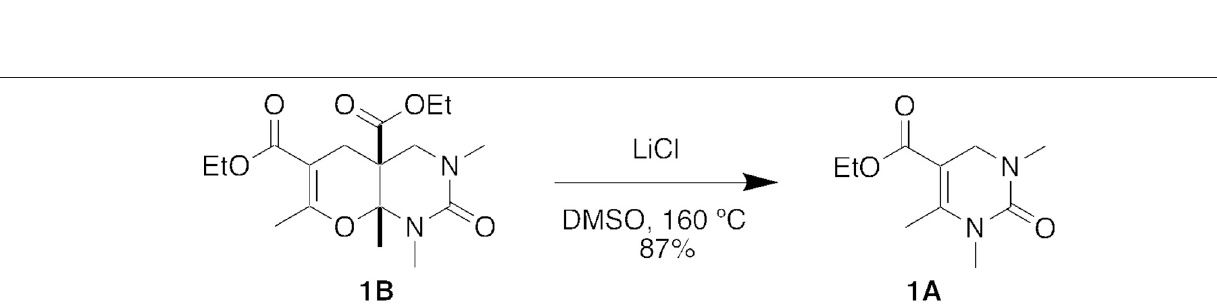
Frontiers in Chemistry |